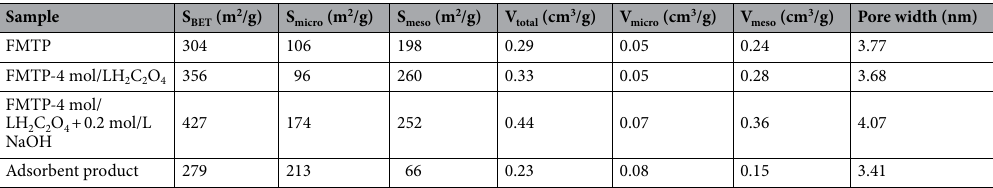
Table 1. BET specific surface area and pore structure parameters of adsorbent